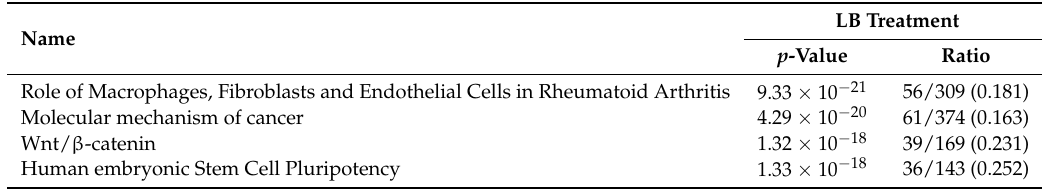
Table 6. Top gene Canonical Pathways associated with Lactobacilli treatment—Ingenuity Pathway Analysis (IPA).